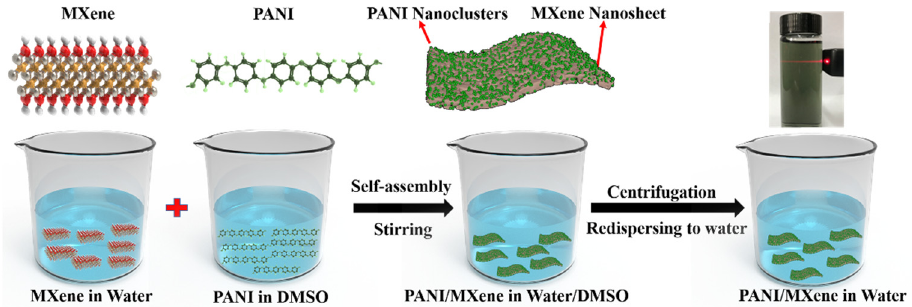
Figure 1. Schematic of the synthesis of PANI/MXene composites.